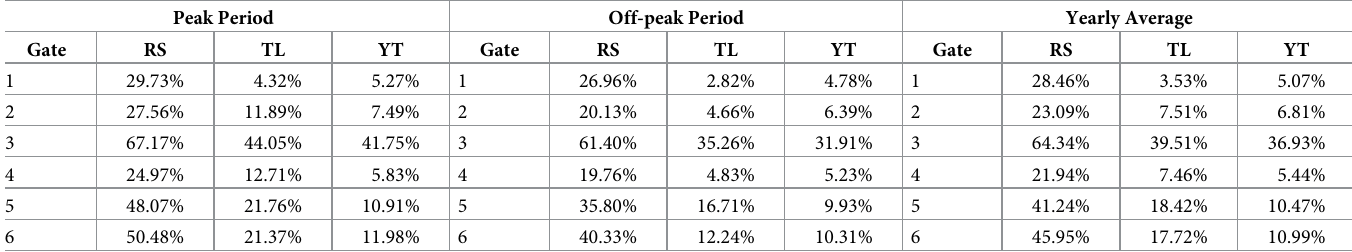
Table 8. Simulation results for scenario